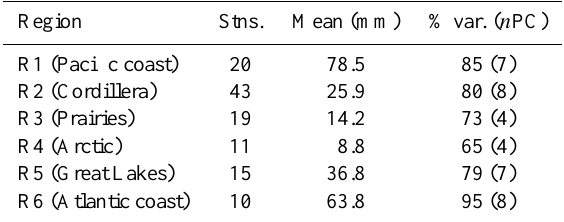
Table 1. Number of stations, mean winter precipitation, and per- centage variance of the winter extreme precipitation anomalies ex- plained by the first several PCs (with n PC being the number of PCs chosen as predictands based on cross-validation), for each of the six regions over Canada. Region